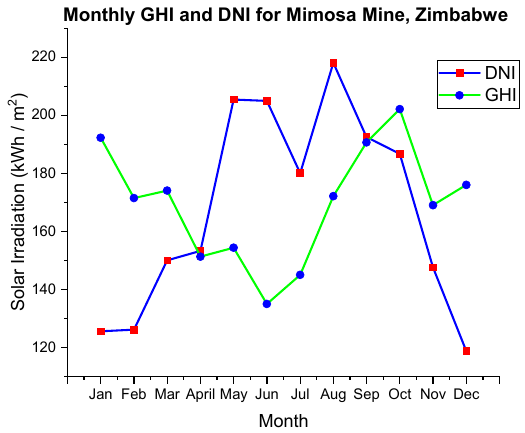
Figure 2. Monthly GHI and DNI for the Mimosa mine. The two figures below (Figures 3 and 4) show the typical hourly variation of DNI, GHI and the temperature during a day in summer and winter at the candidate site. For both figures, the GHI and DNI peak occurs around midday. The temperature in winter is below 25 ◦ C which could help the PV system to perform better. However, the temperature in summer has a peak value of 35 ◦ C which could affect the performance of the PV system.